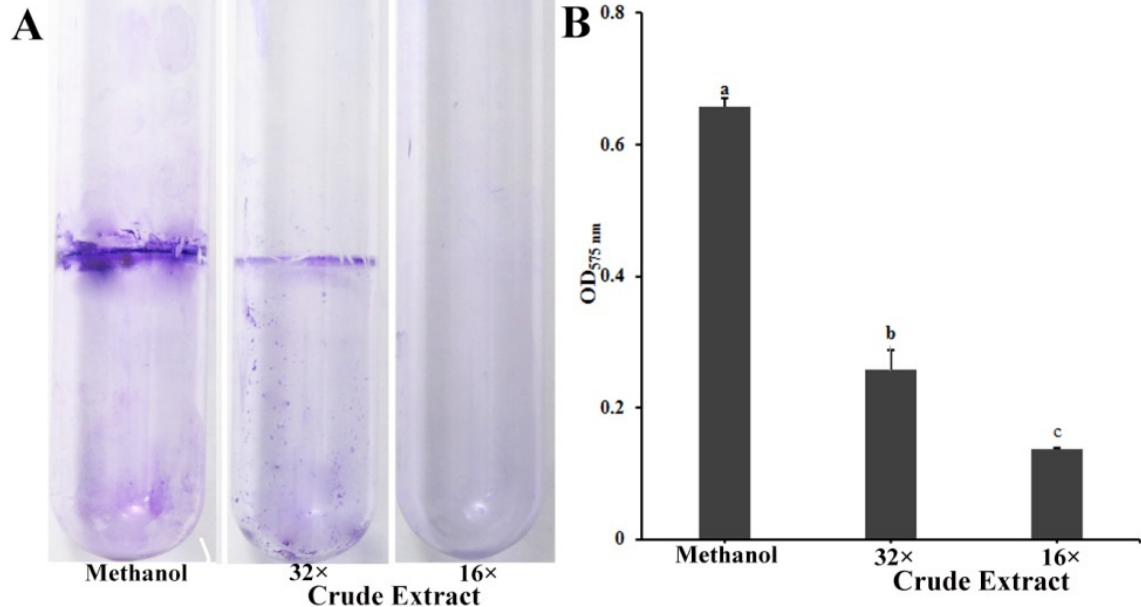
Figure 3. Effect of crude extract prepared from P. protegens Pf-5 on the biofilm formation of P. ananatis DZ-12. ( A ) Biofilm on the inner surface of glass tubes were stained with crystal violet and photographed; ( B ) The graph data show the average OD 575 nm value ± standard deviation (SD) of three replicates. A concentration of 32× and 16× dilutions of the crude extract from P. protegens Pf-5 were used. Different letters represent statistically significant differences according to the one-way ANOVA test ( p < 0.05).